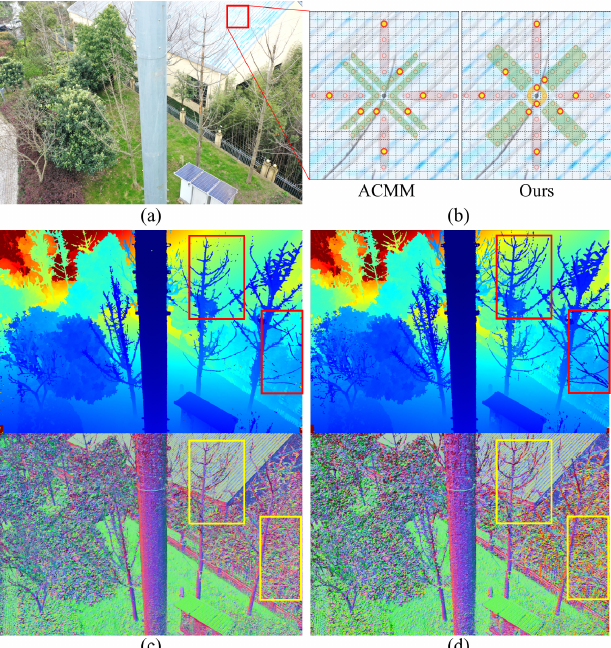
Figure 2. Illustration of our PatchMatch sampling strategy: ( a ) A source image view of case “B5 Tower”. ( b ) The ACMM [50] sampling strategy of a pixel in the red rectangle of ( a ), and our improved sampling strategy. ( c ) The estimated depth map and normal map by ACMM. ( d ) Our estimated depth map and normal map, which contain better details highlighted in the red and yellow